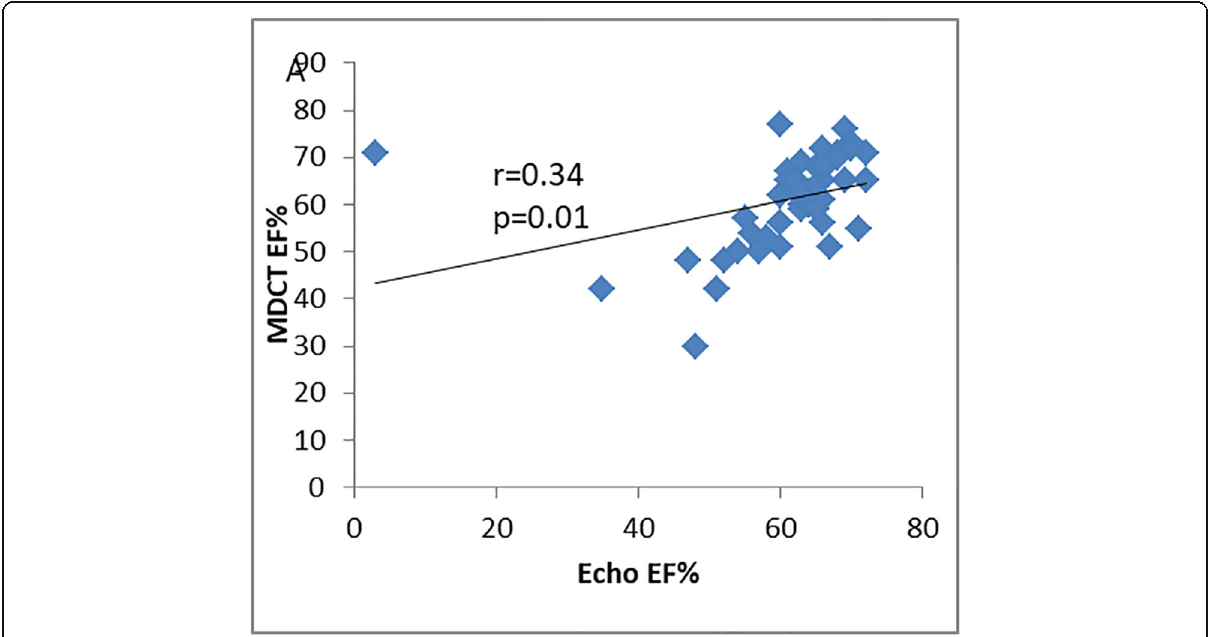
Fig. 3 Linear regression plot comparison between MDCT and 2D echocardiography assessment of LVEF. A positive correlation between LVEF as measured by MDCT and 2D echocardiography ( r = 0.34, p =